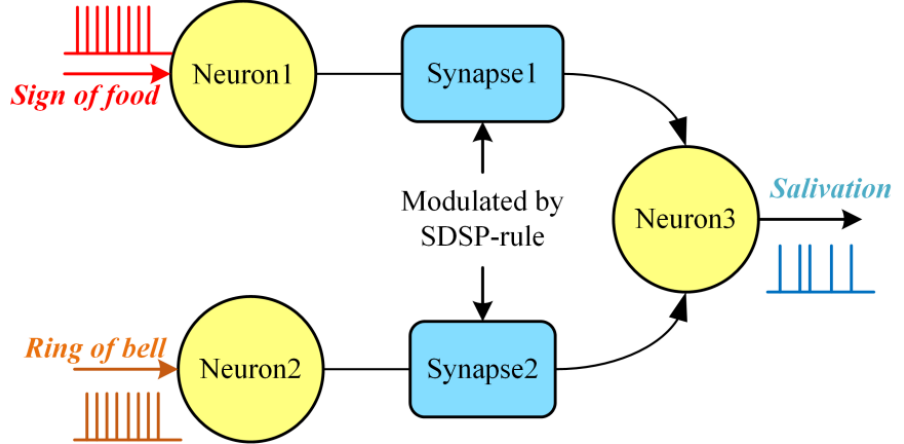
Figure 5. Pavlov SNN network model.